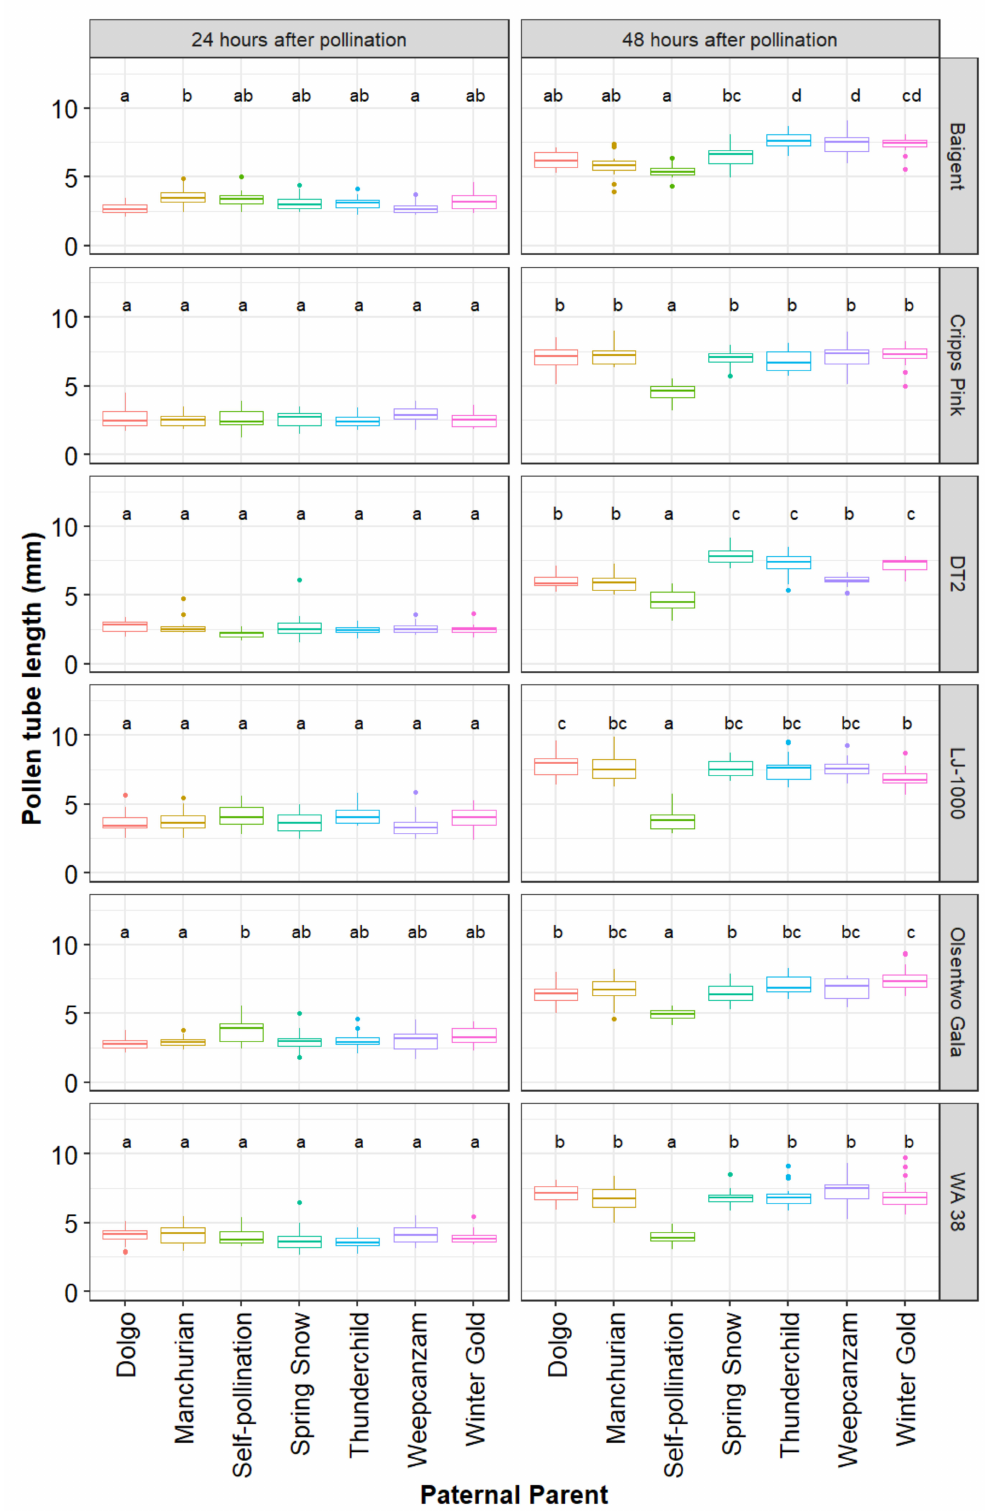
Figure 3. Parentage effects on pollen tube growth. Six maternal parents (‘Baigent’, ‘Cripps Pink’, ‘DT2’, ‘LJ-1000’, ‘Olsentwo Gala’, and ‘WA 38’) were cross-pollinated using pollen from six paternal crabapple parents (‘Dolgo’, ‘Manchurian’, ‘Spring Snow’, ‘Thunderchild’, ‘Weepcanzam’, and ‘Winter Gold’) and a self-pollinated control. Flowers were collected 24 and 48 h after pollination. Different letters indicate significant differences between paternal parents within a time point and maternal parents (Tukey test, α =